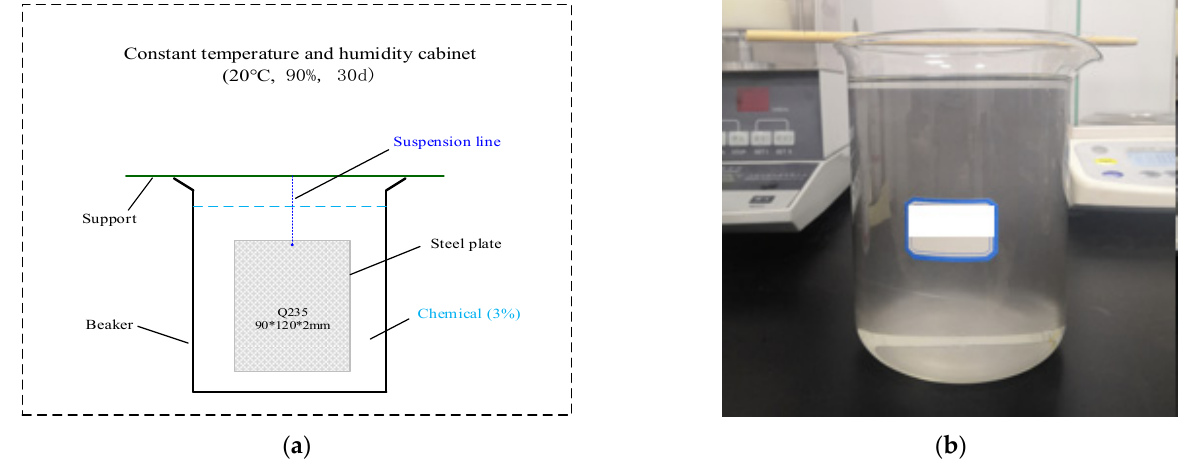
Figure 5. Monthly corrosion rate of Q235 steel experiment. ( a ) The experimental schematic diagram; ( b ) The experimental figure.